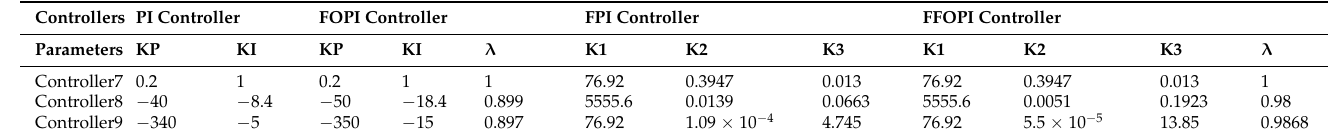
Table 6. Controller gains of AC line for PI, FOPI, FPI, and FFOPI controllers.